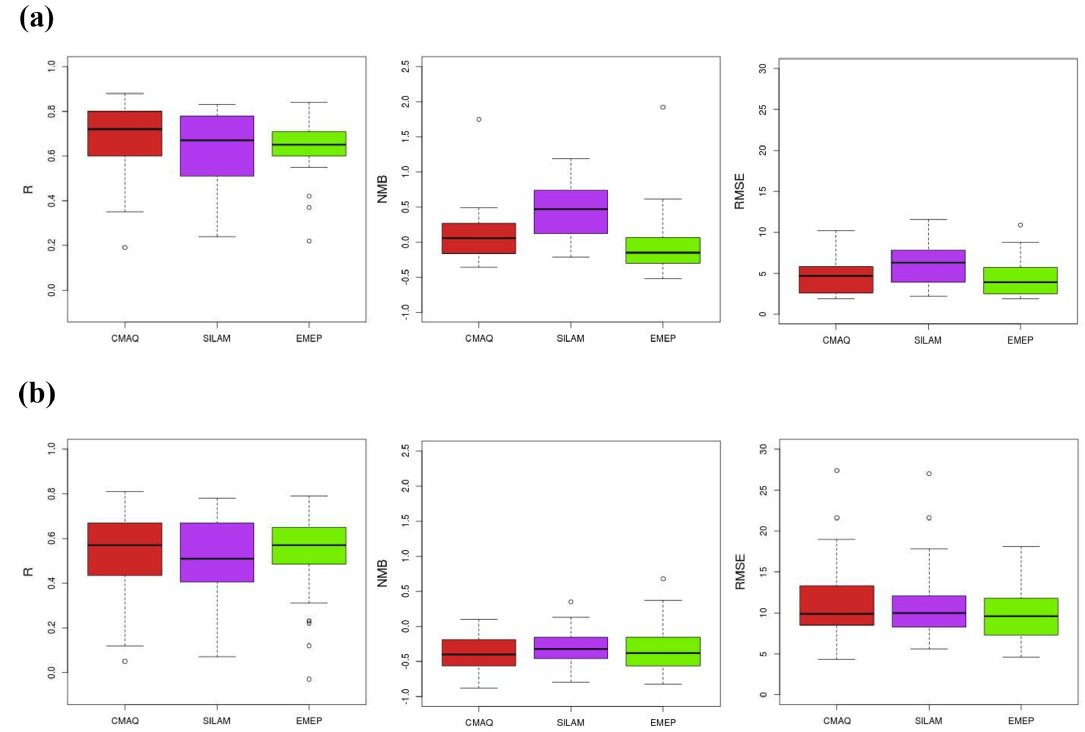
Figure 3. Comparison of statistical indicators for NO 2 daily means (in the order R , NMB and RMSE) between three CTMs at (a) rural background stations and (b) urban background stations. Outliers shown as small